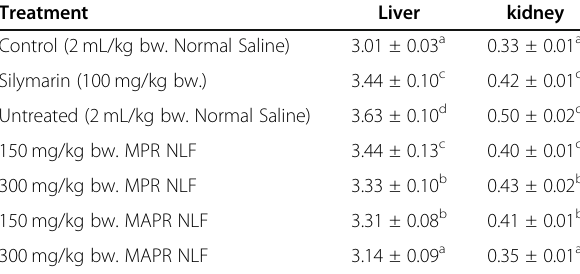
Table 5 Relative liver and kidney weight (%) of male Wistar rats administered with lead acetate and treated with methanol and methanol/acetone phenolic-rich extracts of N. latifolia fruit Treatment Liver kidney Control (2 mL/kg bw. Normal Saline) Silymarin (100 mg/kg